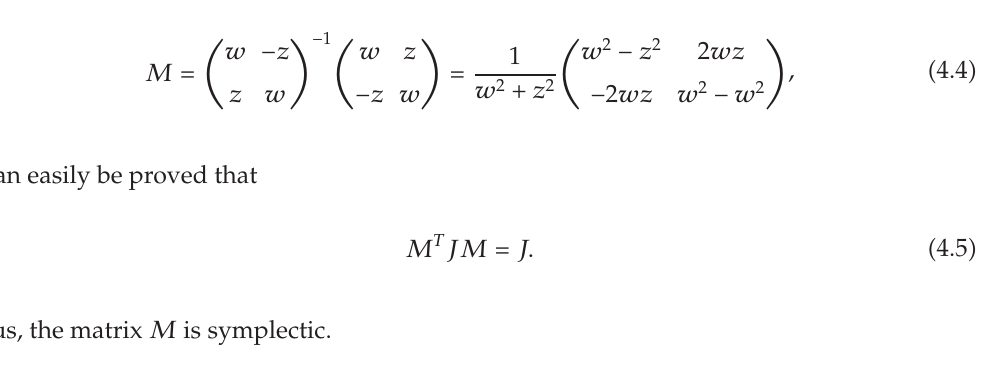
Figure 1: Behavior of the coe ffi cients of the new proposed method given by (cid:4) 3.8 (cid:7) for several values of w .